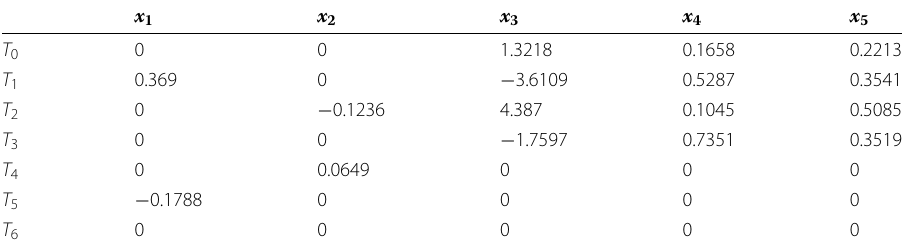
Fig. 9 Problem defined in Eq. (4.4): Comparison of predicted s 2 -PGD values with the reference ones in the testing set (the black line represents a perfect prediction) Table 2 Example of mode enrichment when constructing the s 2 -PGD solution of problem defined in Eq.